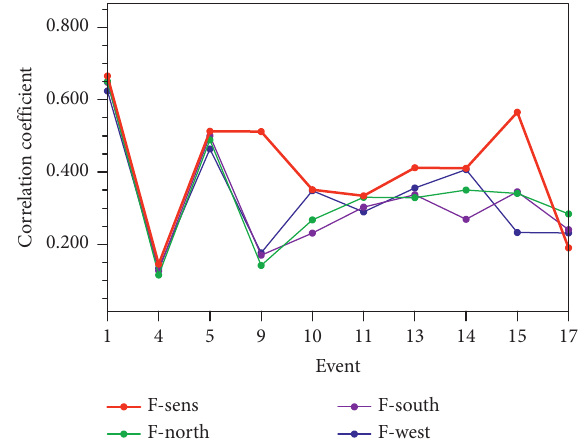
Figure 5: Sensitivity experiment results of 10 improved cases in Table 4, in which the red, green, purple, and blue lines plot the correlation coefficients between the cumulative precipitation re- sults after replacing the sensitive area, northern control area, southern control area, western control area, and OBS in South China,